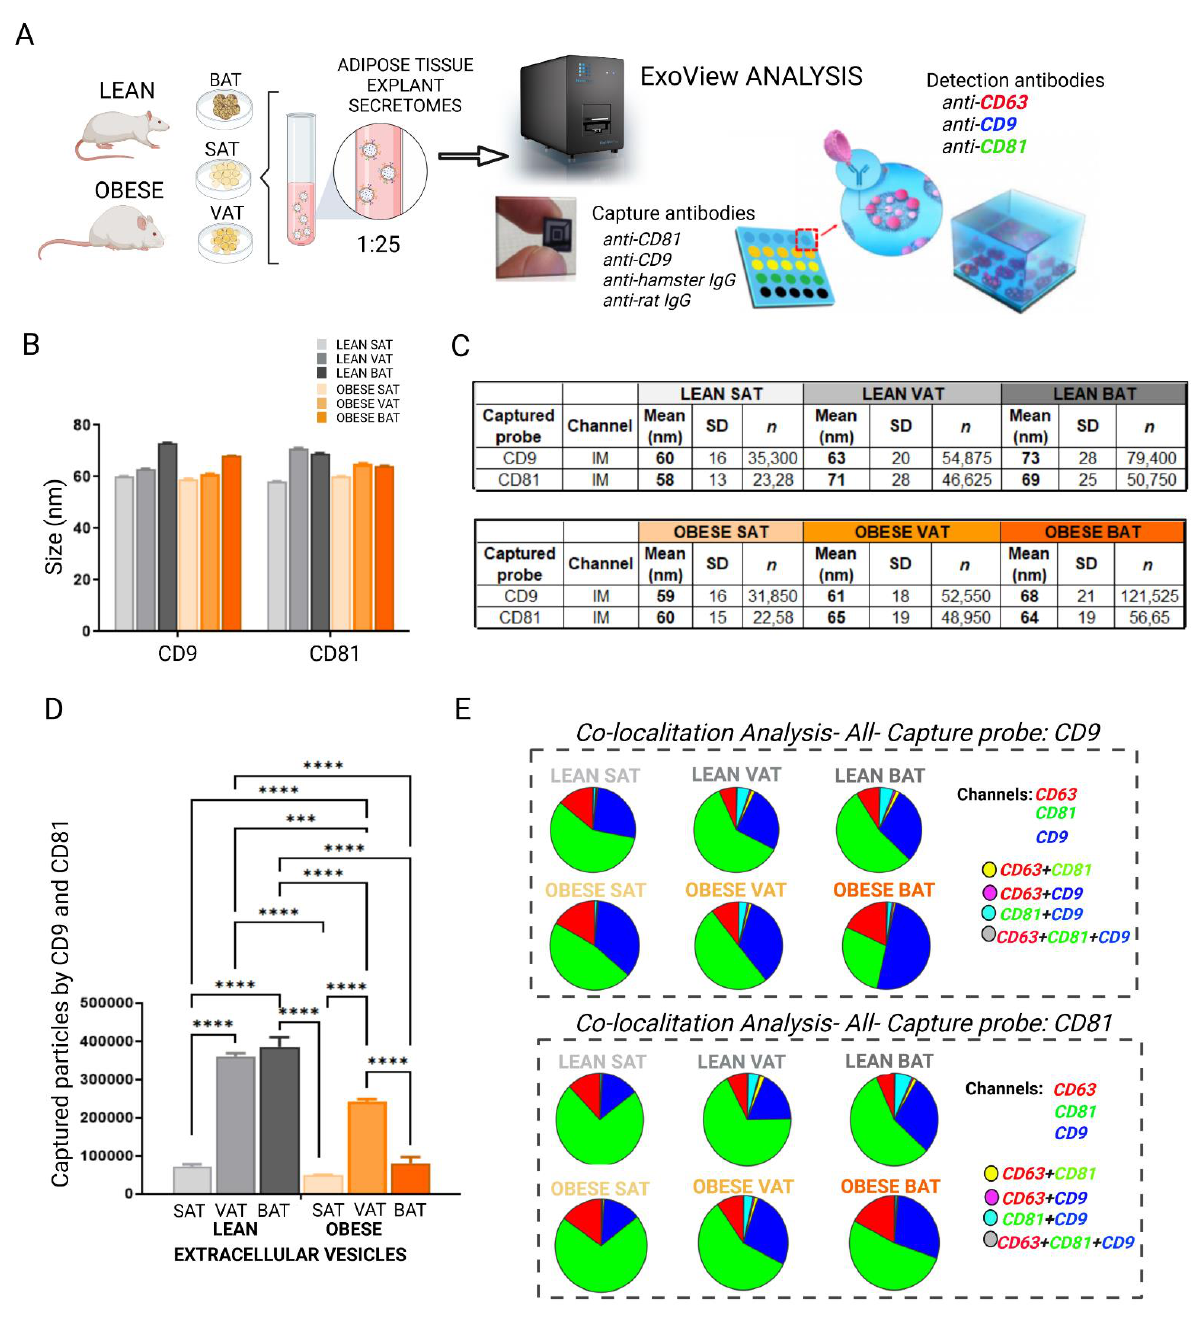
Figure 2. Complete characterization of EVs isolated from white, visceral (VAT), subcutaneous (SAT), and brown (BAT) adipose tissue explants from obese and normal-weight rats using the ExoView platform: ( A ) The ExoView technology allowed the analysis of the size, captured particle concentration, and co-localization of tetraspanins CD63, CD9, and CD81 of the different EVs isolated from white and brown adipose tissue explants from obese and control rats, by immunocapture with anti-CD9 and -CD81 on individualized chips. ( B , C ) the size of EVs was analyzed according to the CD9- or CD81-captured antibody by interferometry; ( D ) the number of particles captured by CD9 and CD81 tetraspanins; ( E ) co-localization of CD63 (red), CD81 (green), and CD9 (blue) tetraspanins on EVs was analyzed according to their capture by CD9 or CD81. At least 4 independent assays were performed for each condition, and differences were analyzed using a one-way ANOVA and Kruskal–Wallis test, p ≤ 0.05 was considered to be statistically significant (*** p < 0.001; **** p < 0.0001) (created with